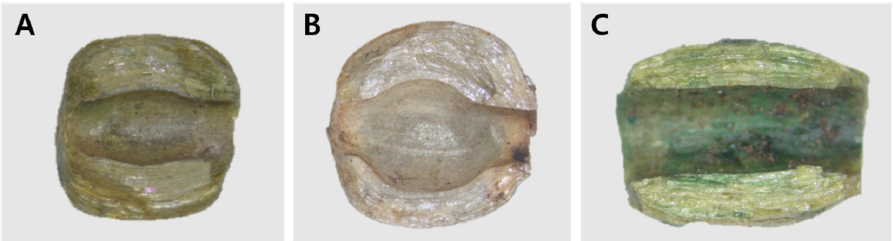
Figure 5. Morphological characteristics of silver foil beads from the tomb of King Muryeong in Korea; ( A ): Gold-colored, ( B ): Silver-colored type I, ( C ): Silver-colored type